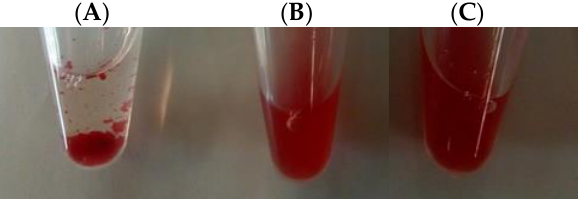
Figure 4. Photos of hemagglutinating assays carried out in 1.5 mL Eppendorfs with native frutalin ( A ), TrxFTL ( B ), and cFTL ( C ) for the higher concentration tested (0.2 mg/mL). A coagulum at the bottom of the Eppendorf is clearly visible in the presence of native frutalin ( A ), but not in the presence of TrxFTL ( B ) and cFTL ( C ).